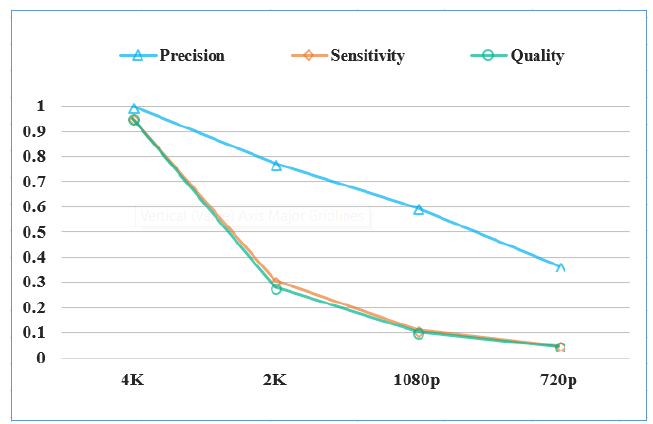
Figure 9. Detection performance in different resolutions.